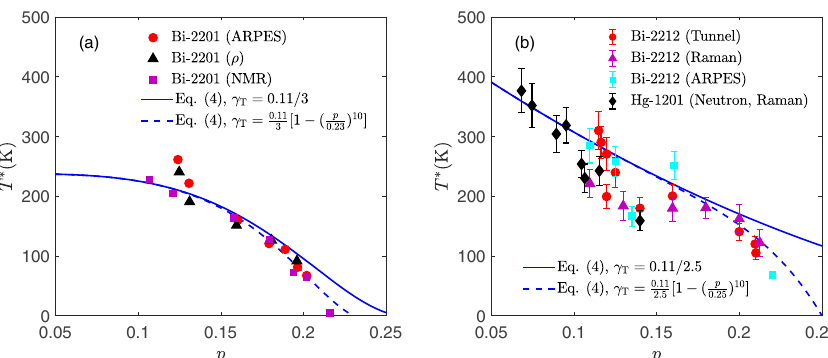
Fig. 3 Doping ( p ) dependence of the pseudogap onset temperature T * . a The symbols represent Bi-2201 data determined from previously reported measurements 43 . The solid blue line represents the predictions from Eq. (4) with the scattering parameter γ T = 0.11/3, the effective mass m * = 2.7 m e ( m e is the electron mass), and a power-law model Q CDW = 0.269[1 − ( p /0.261) 3.79 ] of the charge density wave (CDW) vector. The root mean squared error for solid and dashed lines are 30 and 20 K, respectively. b The symbols represent Bi-2212 and Hg-1201 data determined from previously reported measurements 15 . Besides, the vertical errors are extracted from these measurements 15 as well. The solid blue line represents the prediction from Eq. (4) with γ T = 0.11/2.5, m (cid:2) = 2.45 m e , and Q CDW = 0.343 − 0.699 p . The dashed blue lines indicate the quick decay of the CDW amplitude near the pseudogap quantum critical point. The root mean squared error for solid and dashed lines are 50 and 40 K, respectively. The acronyms ARPES, ρ , NMR, Tunnel, Raman, Neutron in the fi gure legends represent the data from angle-resolved photoemission spectroscopy, resistivity, nuclear magnetic resonance, tunnelling, Raman and neutron experiments, respectively.